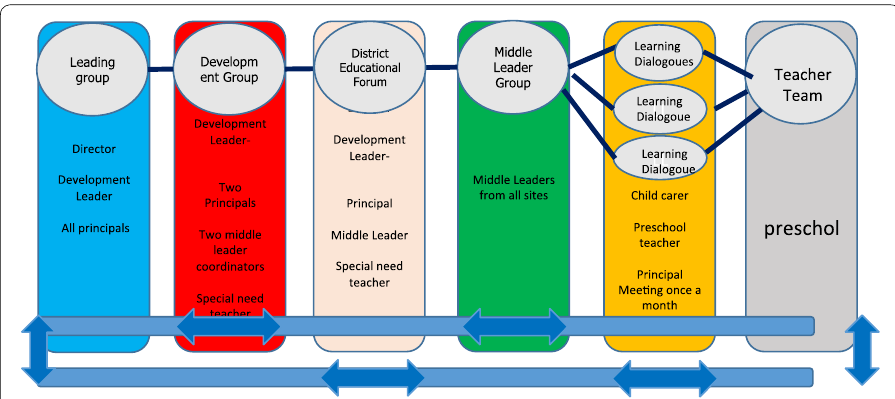
Fig. 1 The organisational structure for developing systematic quality work in the city district